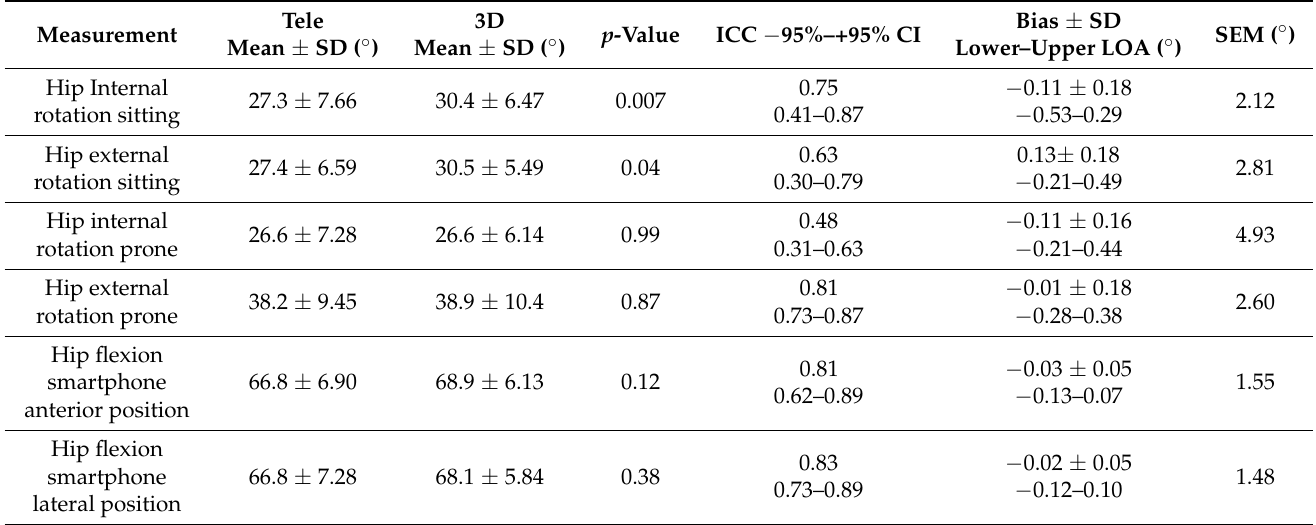
Table 1. Comparison of smartphone (TelePhysio) measurements and gold-standard (3D analysis) measurements: means ± standard deviations, one way ANOVA p -value, ICC and 95% confidence intervals, Bland–Altman fixed bias and 95% LOA, and SEM.